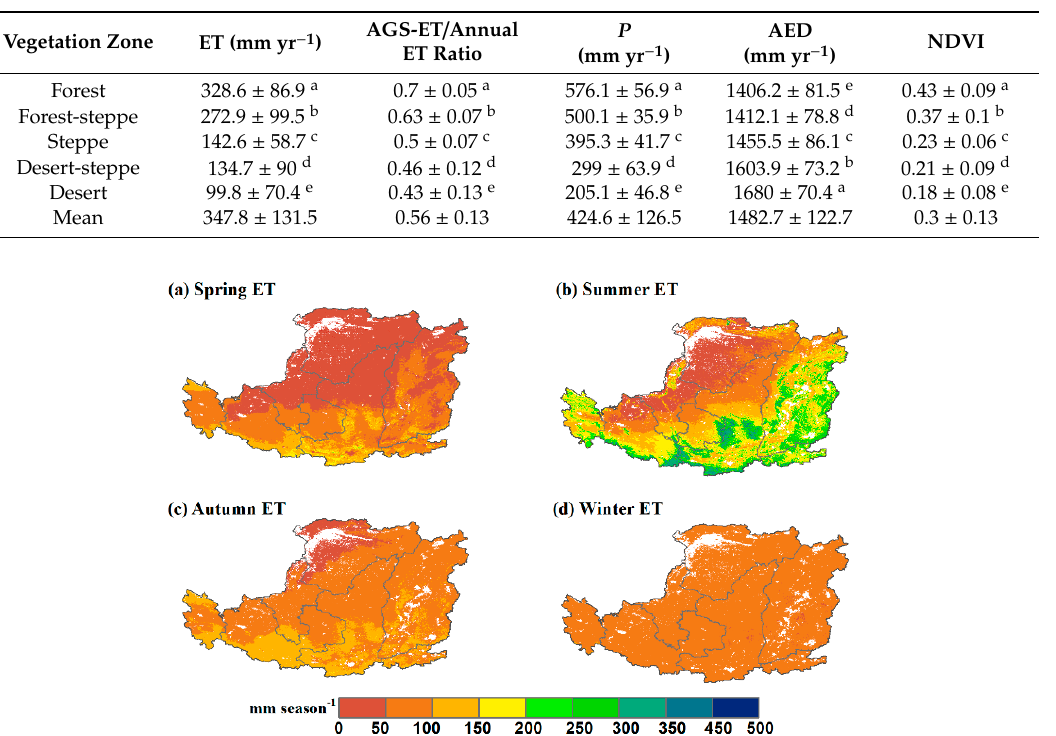
Figure 3. Spatial patterns of ( a ) spring ET, ( b ) summer ET, ( c ) autumn ET, and ( d ) winter ET averaged over 2000–2014 in the Chinese Loess Plateau. Table 1. Statistical characteristics of ET and AGS-ET/Annual ET ratio for different vegetation zones averaged over 2000–2014 in the Chinese Loess Plateau. The P , AED, and NDVI values are also provided for reference. Different superscript letters denote a statistically significant difference at a 5% confident level based on Tukey’s multiple comparison tests.